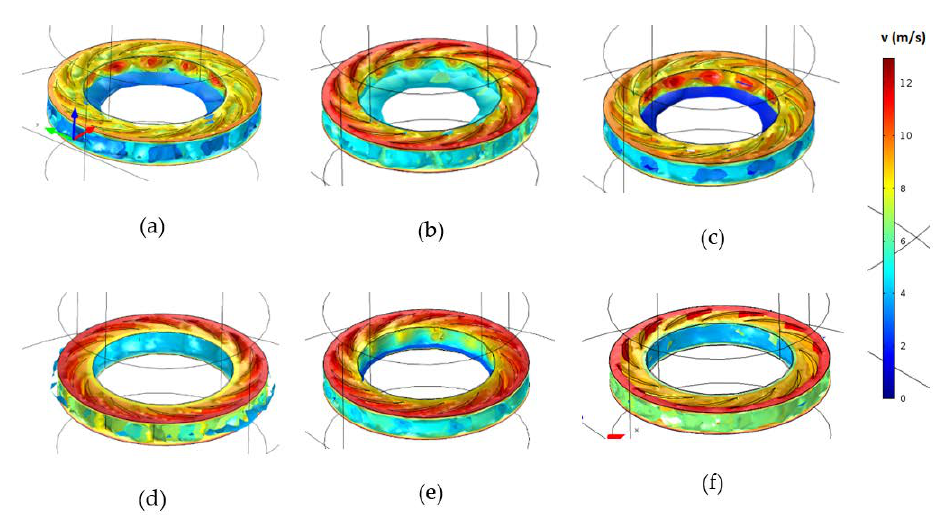
Figure 5. Velocity isosurfaces in the turbine runner for different rotational speeds: ( a ) N = 750 rpm; ( b ) N = 1050 rpm; ( c ) N = 1500 rpm; ( d ) N = 1600 rpm; ( e ) N = 1800 rpm; ( f ) N = 1850 rpm.